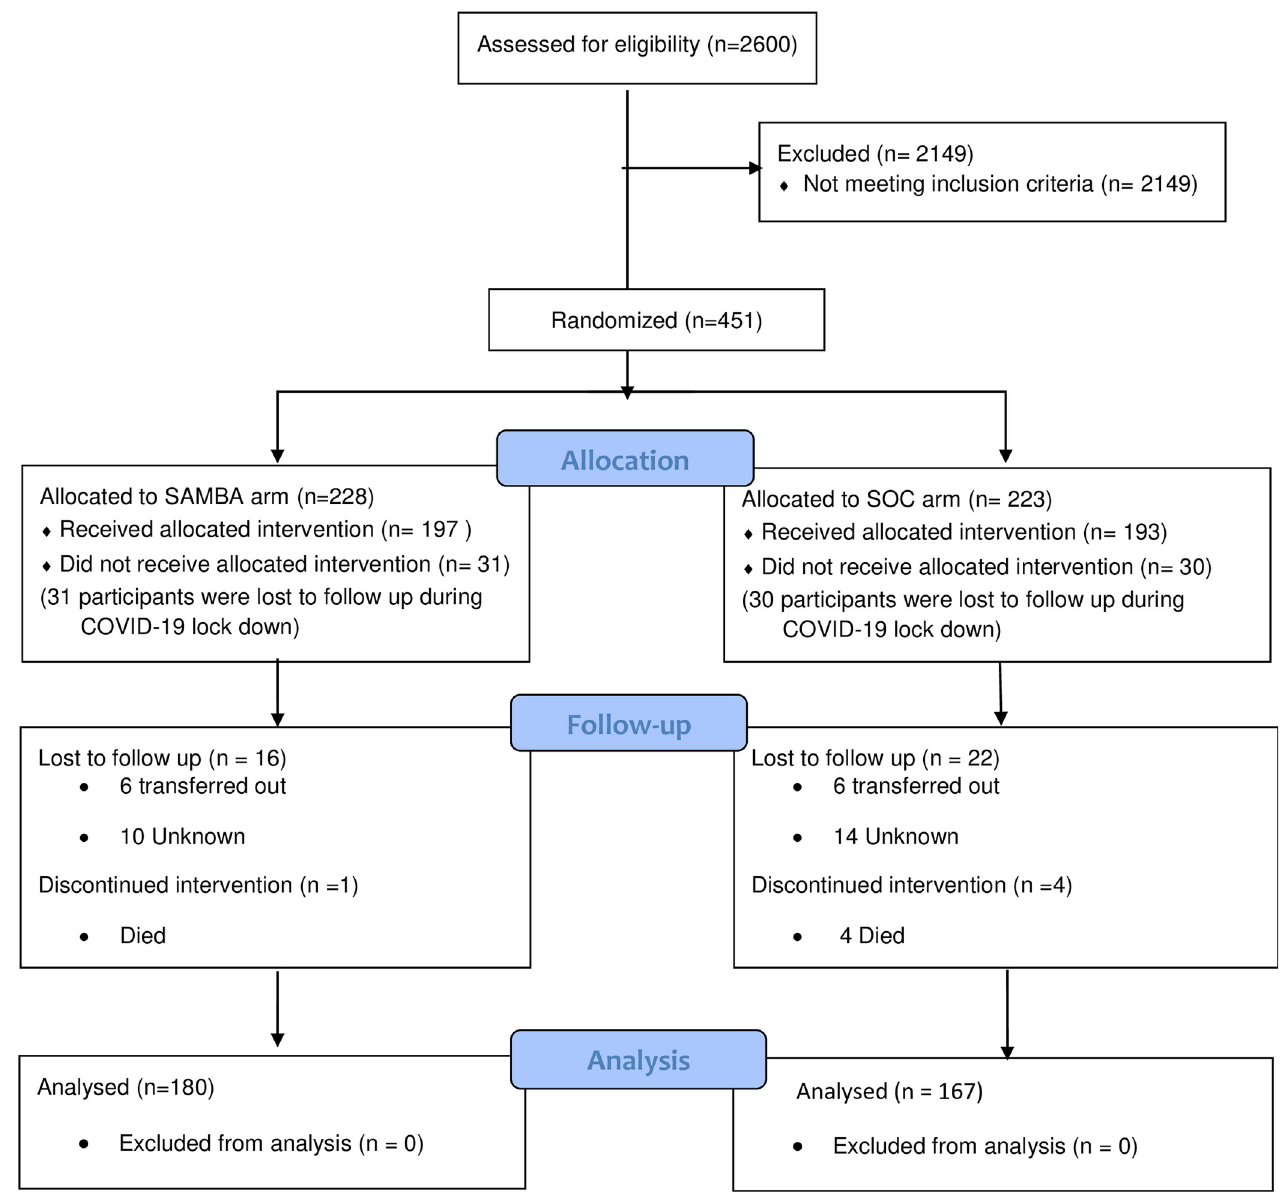
Fig 1. Consort flowchart for the randomized controlled